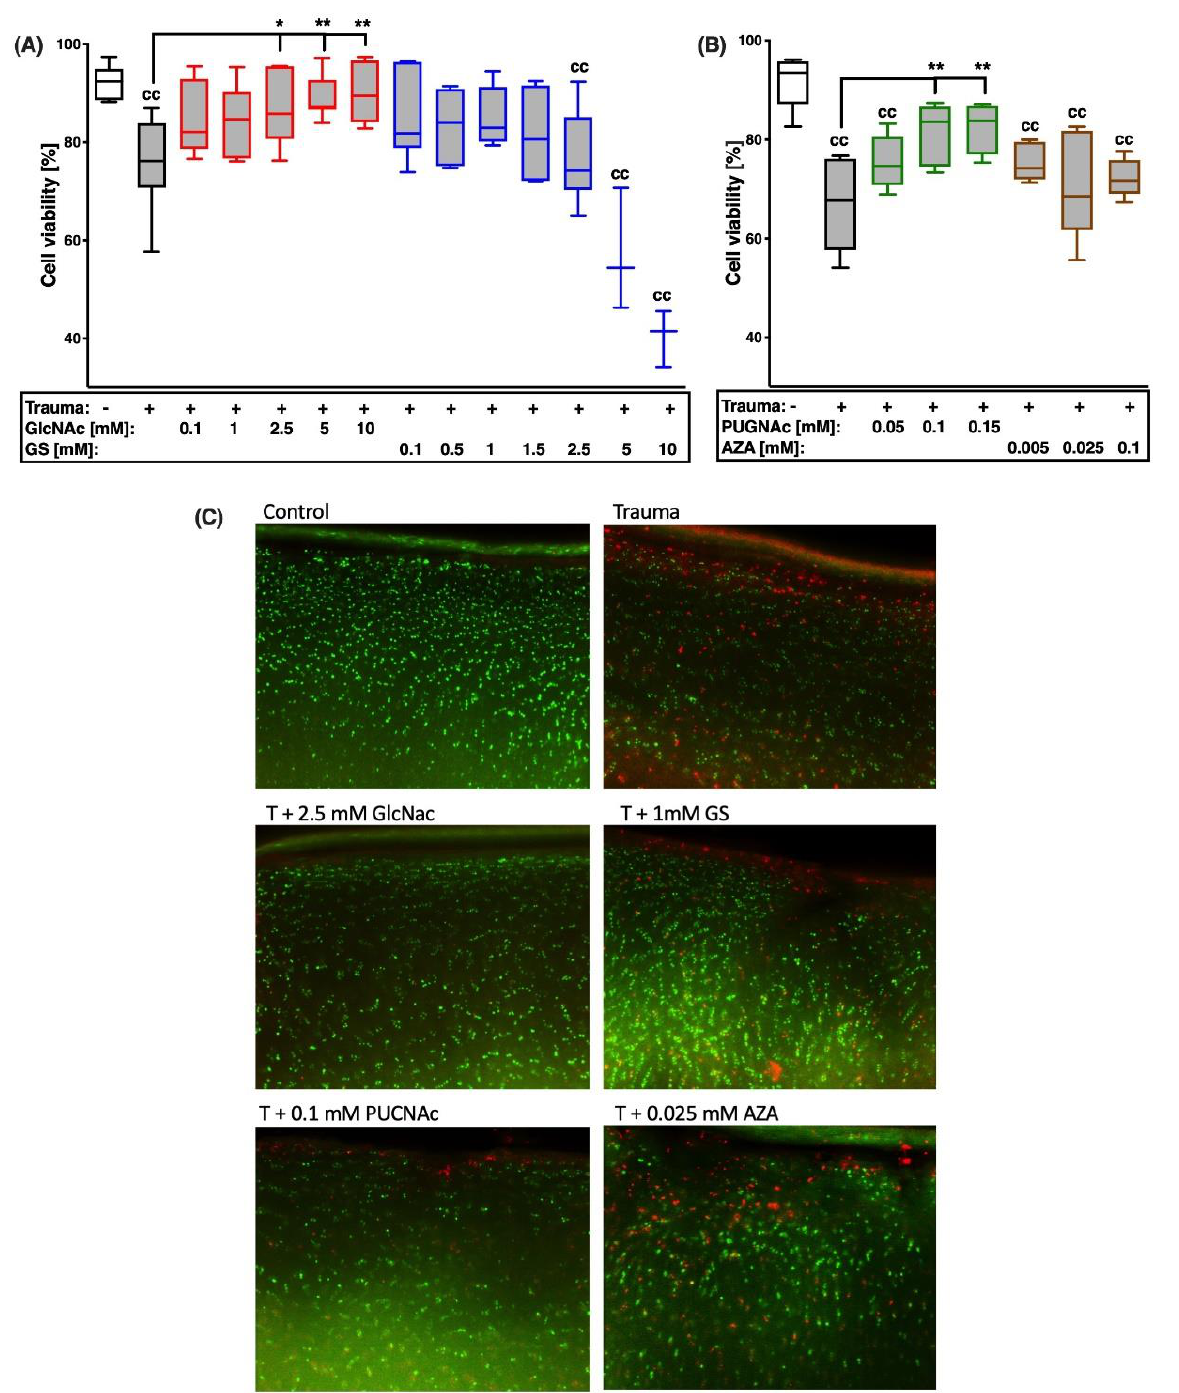
Figure 3. Effects of glucosamine treatment or addition of inhibitors on cell viability 7 days after cartilage trauma. Impacted cartilage explants were treated with different concentrations of ( A ) glucosamine derivatives GlcNAc or GS or ( B ) OGA-inhibitor PUGNAc and GFAT-1-Inhibitor AZA, respectively, for 7 days. ( C ) Exemplary fluorescence images of live/dead staining. Statistical analysis: ( A , B ) one-way ANOVA. Significant differences between groups were depicted as: [versus T] * = p < 0.05, ** = p < 0.01; [versus C] cc = p < 0.01; all data sets n ≥ 5, except for 5 mM and 10 mM GS, n = 3. Blank box = unimpacted control (C), shaded boxes = traumatized cartilage explants (T).